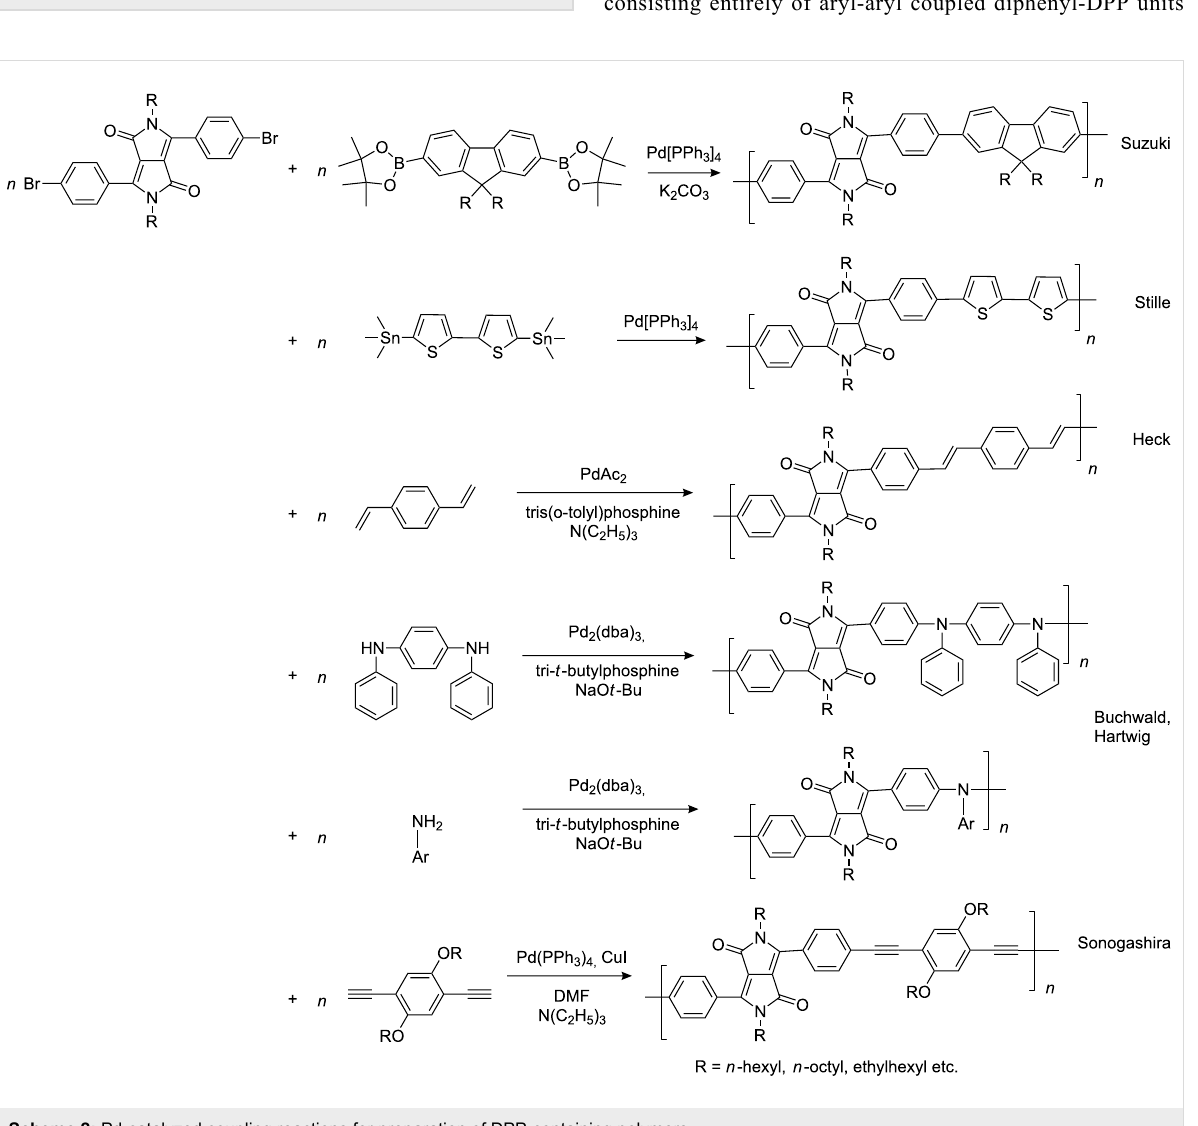
Figure 2: Plot of current density and light intensity versus voltage of polymer light-emitting diode containing P-5 : ITO/ P-5 /OXD7/Ca/ Mg:Al:Zn (from